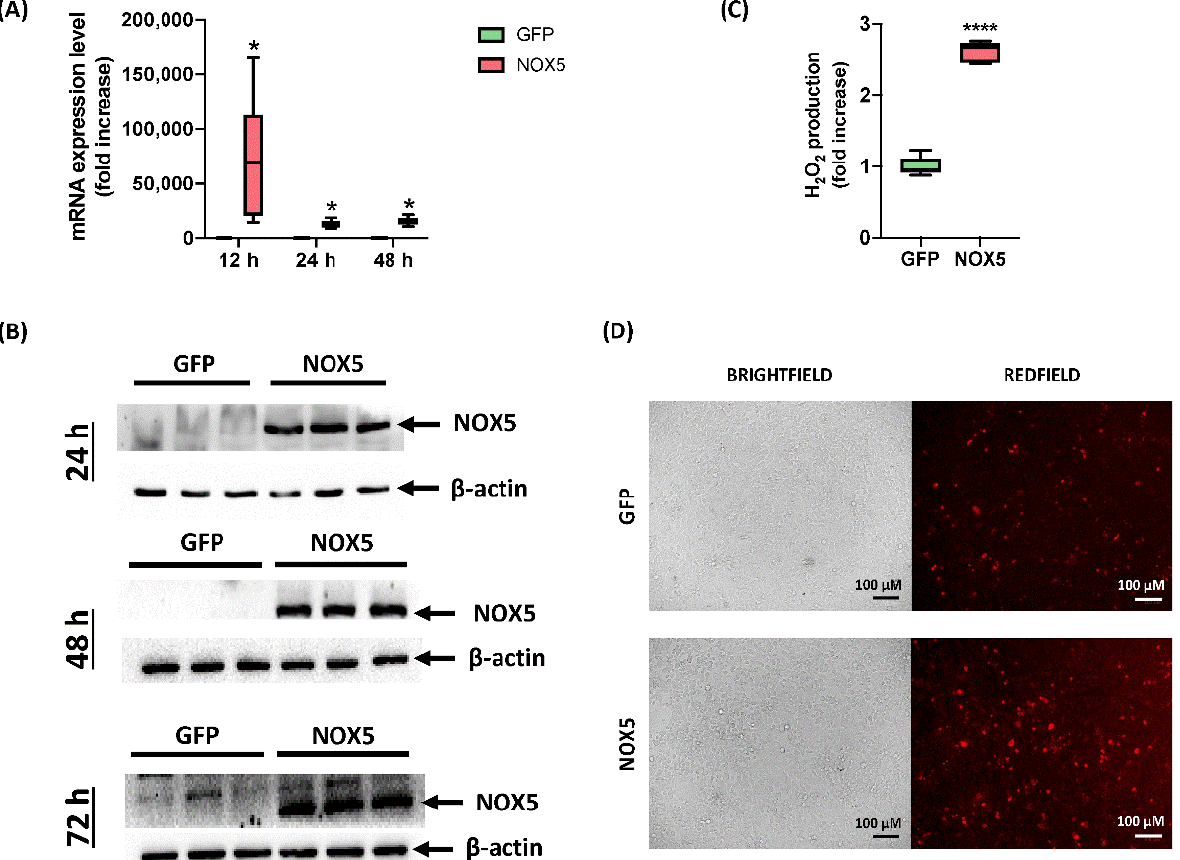
Figure 1. Characterization of hCMEC/D3 infection with GFP and NOX5- β adenoviruses. ( A ) NOX5 mRNA expression level after 12, 24 and 48 h of infection ( n = 6). ( B ) NOX5 and β -actin immunoblots after 24, 48, and 72 h of infection ( n = 3). ( C ) Extracellular H 2 O 2 production after 24 h of infection, measured by AmpliFluRed TM ( n = 6). ( D ) Superoxide detection by DHE staining after 24 h of infec- tion. Left: brightfield. Right: redfield (oxidized DHE). GFP: GFP-infected hCMEC/D3 cells; NOX5: NOX5- β -infected hCMEC/D3 cells; * p < 0.05 vs. GFP-cells; **** p < 0.0001 vs. GFP-cells. Data pre- sented as mean ± SEM.